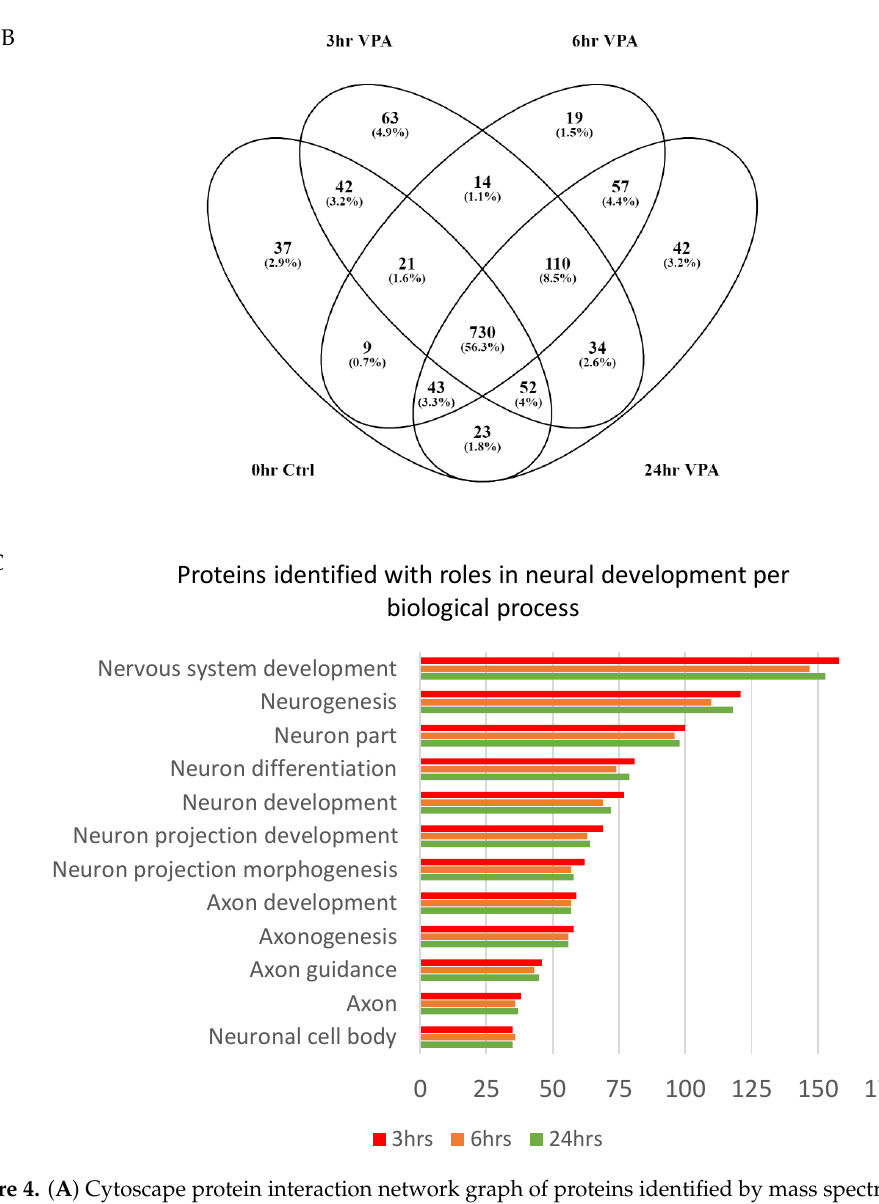
Figure 4. ( A ) Cytoscape protein interaction network graph of proteins identified by mass spectrometry. Blue—ADSC unique, Violet—occurs in two or more time points, Red—3 h unique expression, Orange—6 h unique expression, and Green—24 h unique expression. ( B ) Venn diagram displays breakdown of protein numbers unique and shared between time points. ( C ) Gene ontology biological process analysis of the proteins expressed in Red—3 h, Orange—6 h, and Green—24 h shows a high percentage of proteins linked to neural, neuron, or axon development.